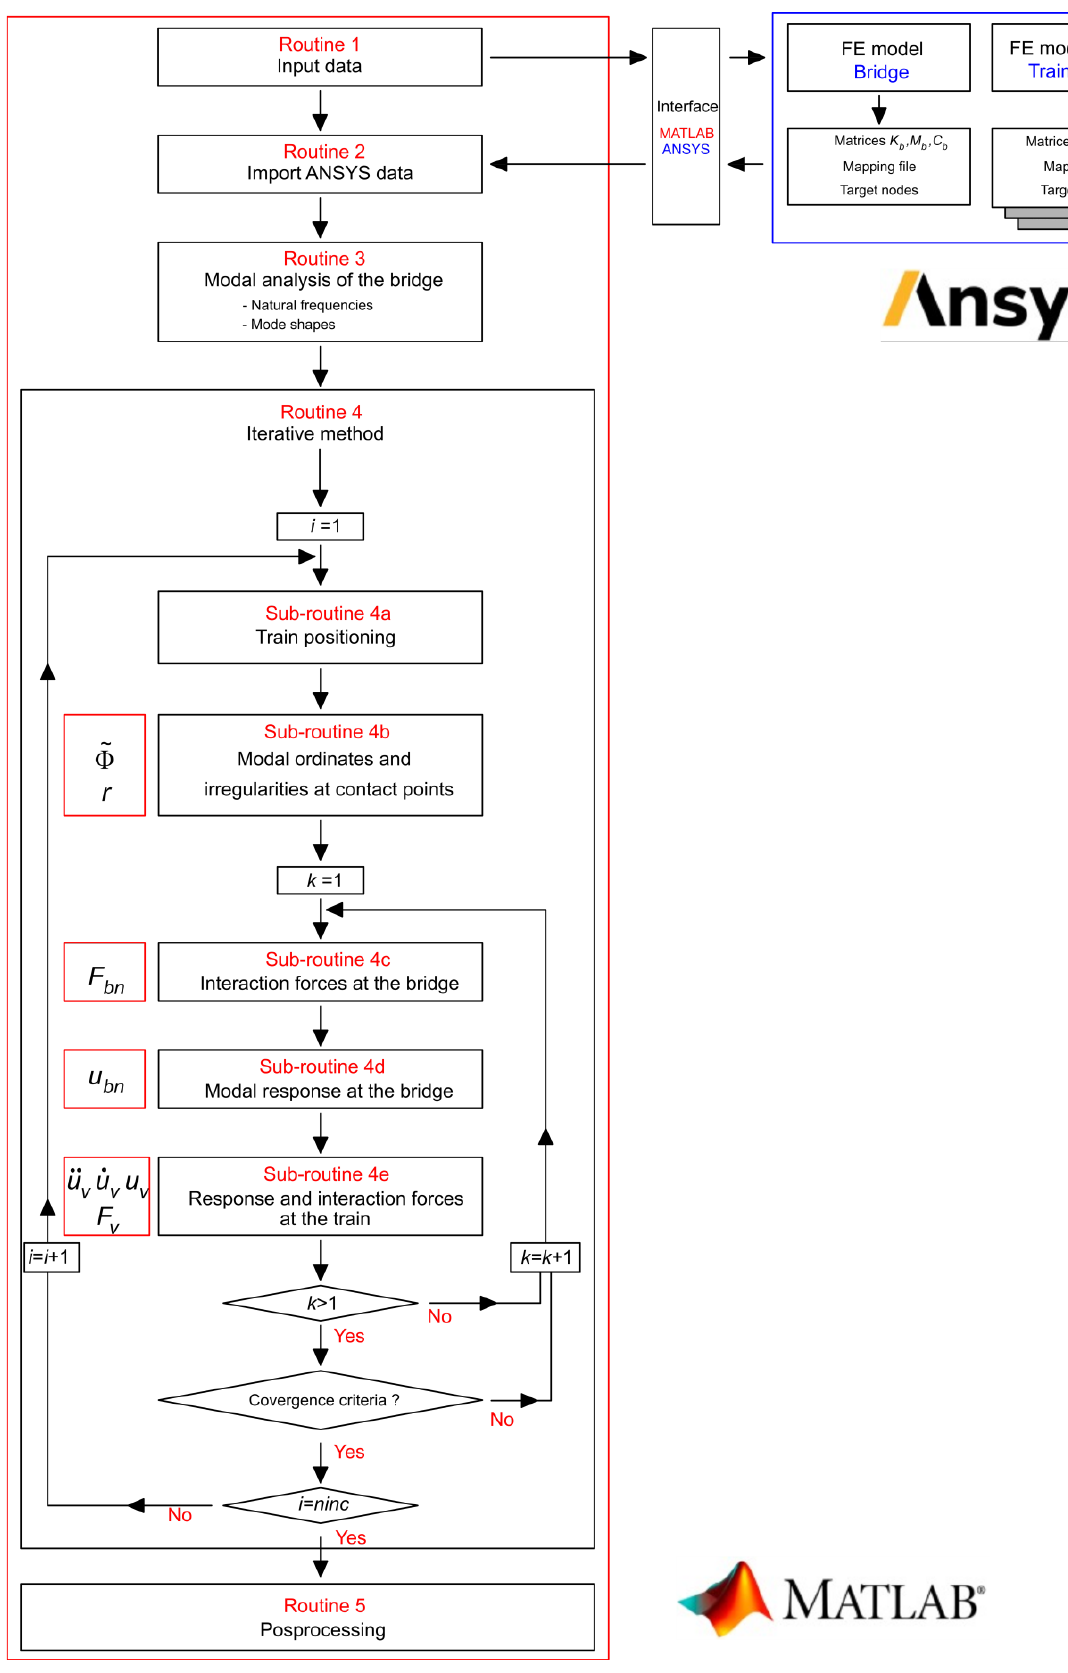
Figure 11. Flowchart of TBI software.